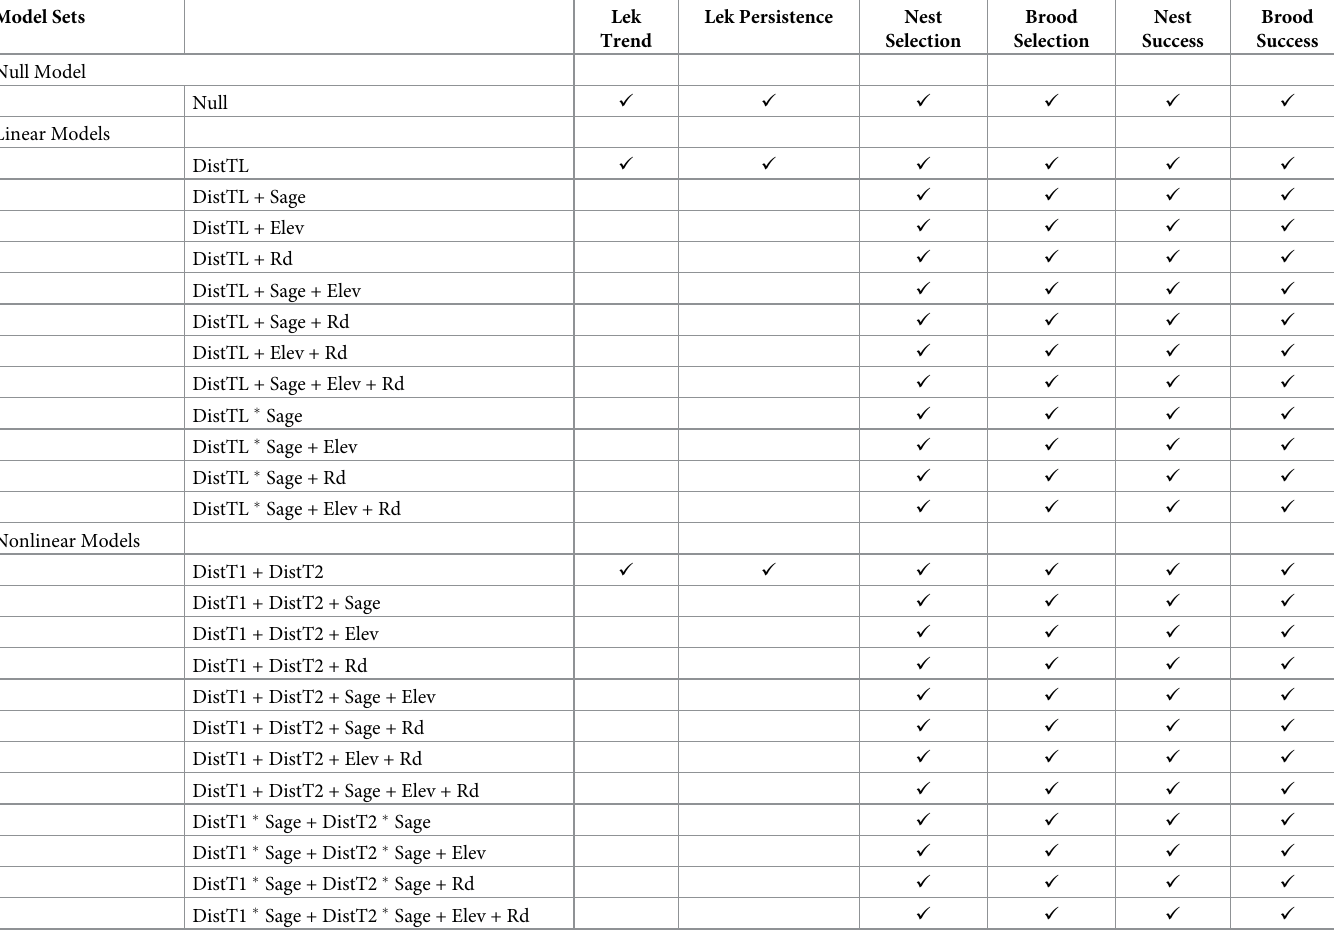
Table 1. Model combinations used to evaluate the influence of power lines on sage-grouse ( Centrocercus urophasianus ) habitat selection and vital rates. Model Sets